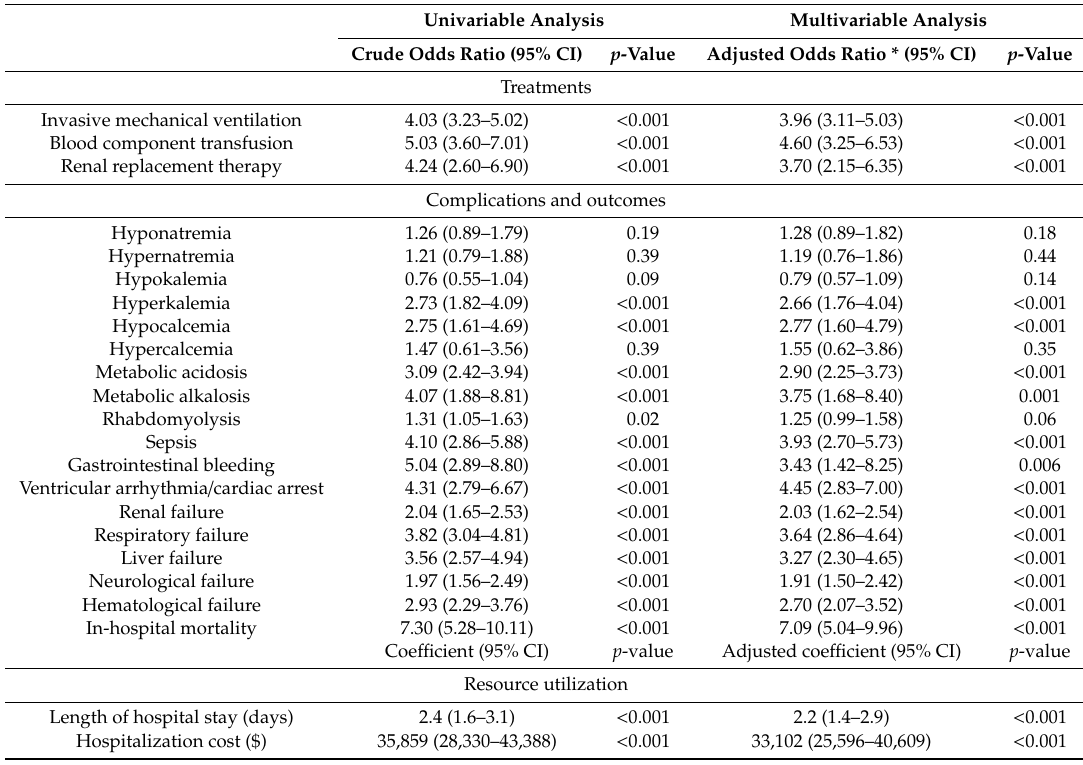
Table 3. The association of circulatory failure with in-hospital treatment, complications, outcomes, and resource utilization in heatstroke